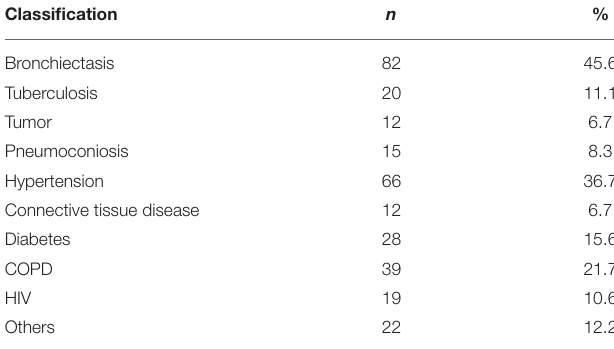
TABLE 2 | Classification of the underlying disease in patients with non-tuberculous mycobacteria (NTM) lung disease.